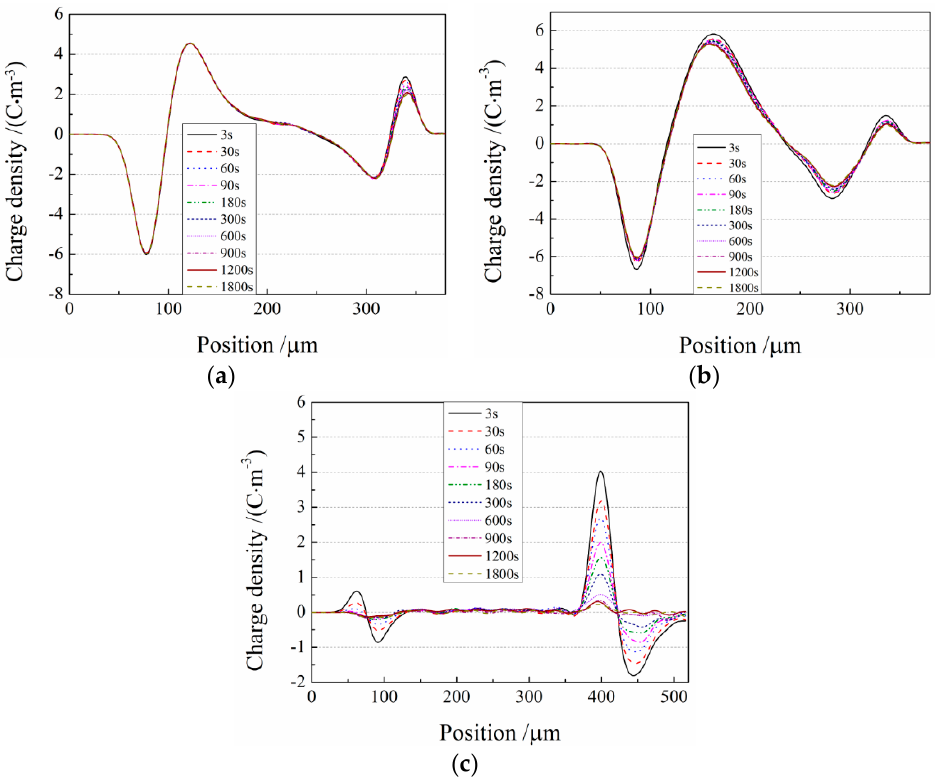
Figure 7. Space charge distributions during depolarization for ( a ) iPP, ( b ) iPP/SEBS, and ( c ) cPP- g -MAH/iPP/SEBS.